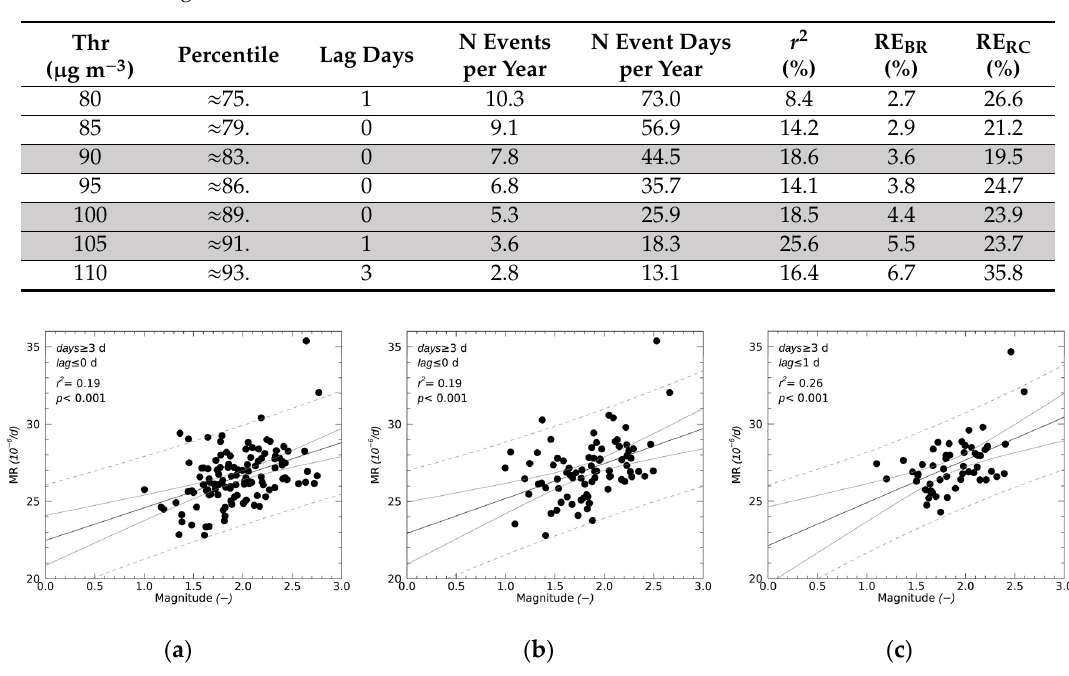
Table 2. Same as Table 1, but for the maximum daily eight-hourly average ozone concentration (MDA8) at site Wedding, urban station #1.